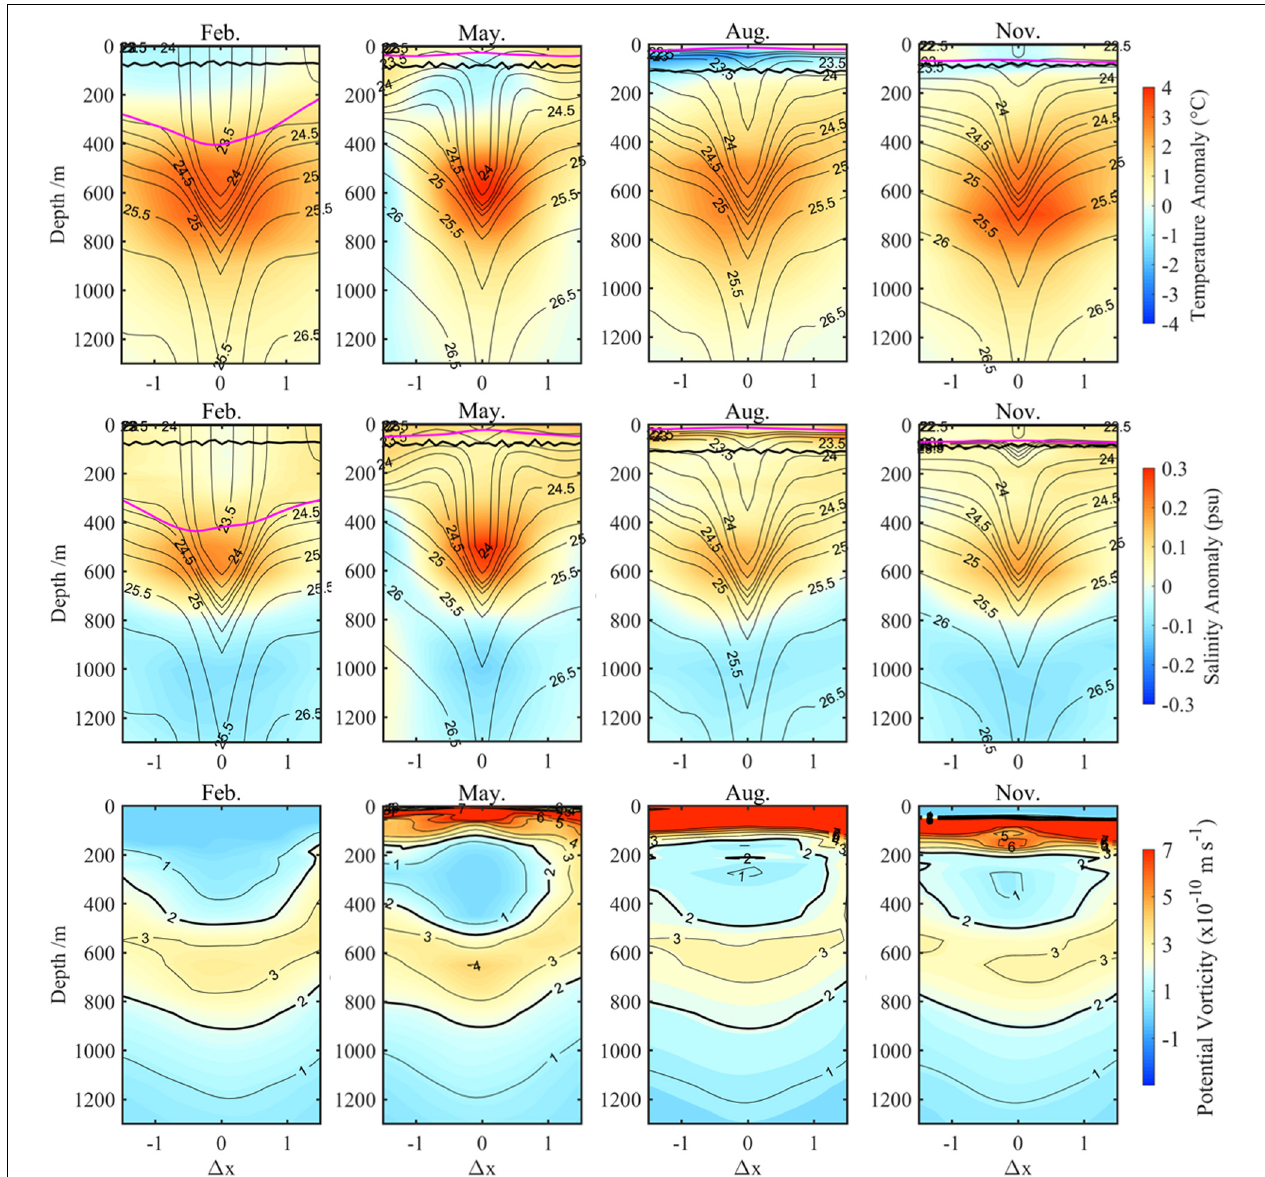
FIGURE 6 | Same as Figure 5 but during the NLM path